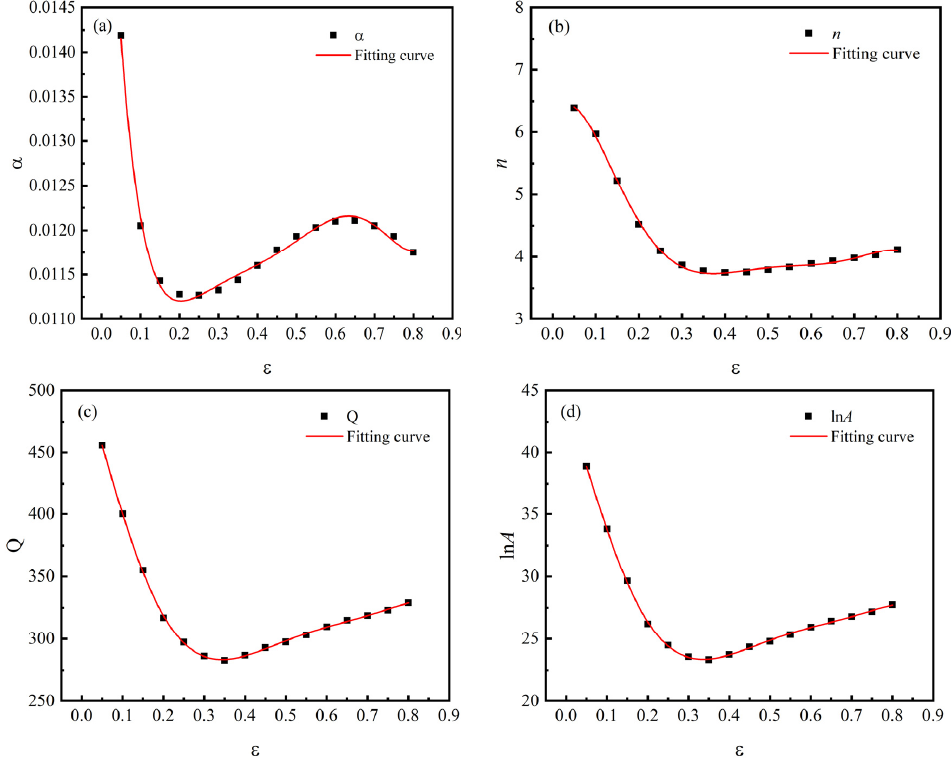
Figure A4. Variations of material constants with strain: ( a ) 𝛼 ; ( b ) 𝑛 ; ( c ) 𝑄 ; ( d ) ln𝐴 .